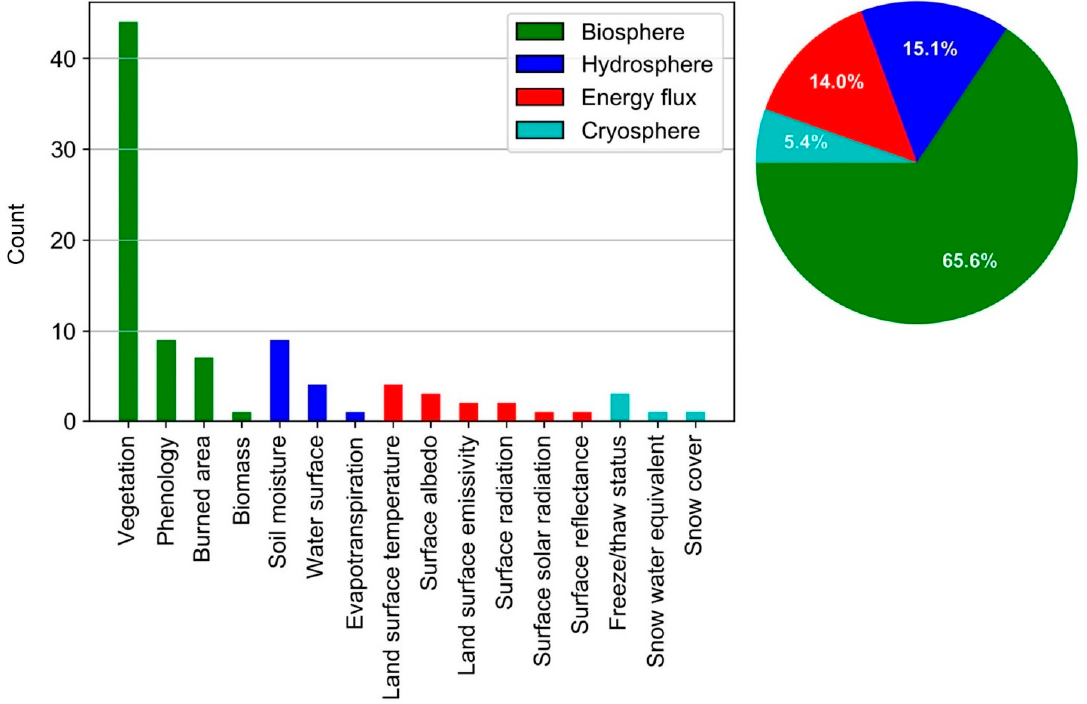
Figure 8. Frequency of research objects in the reviewed studies and their affiliation to superordinate domains.